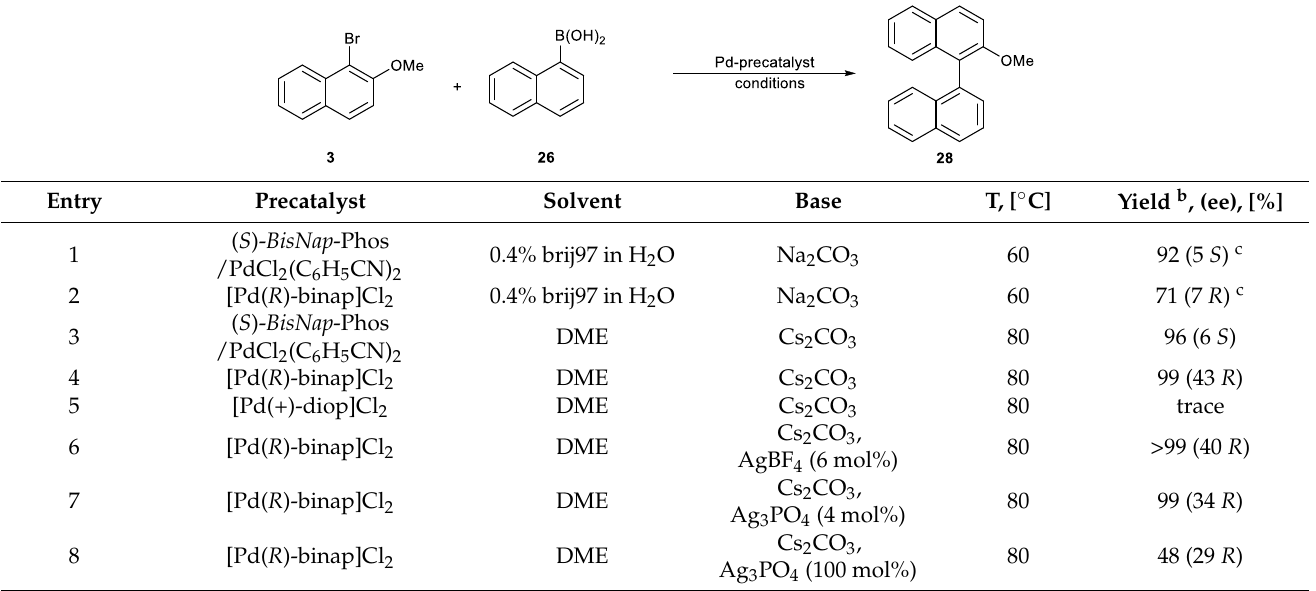
Table 13. Ligand activity in asymmetric synthesis of 2-methoxy-1,1 (cid:48) -binaphthyl ( 28 ) a .